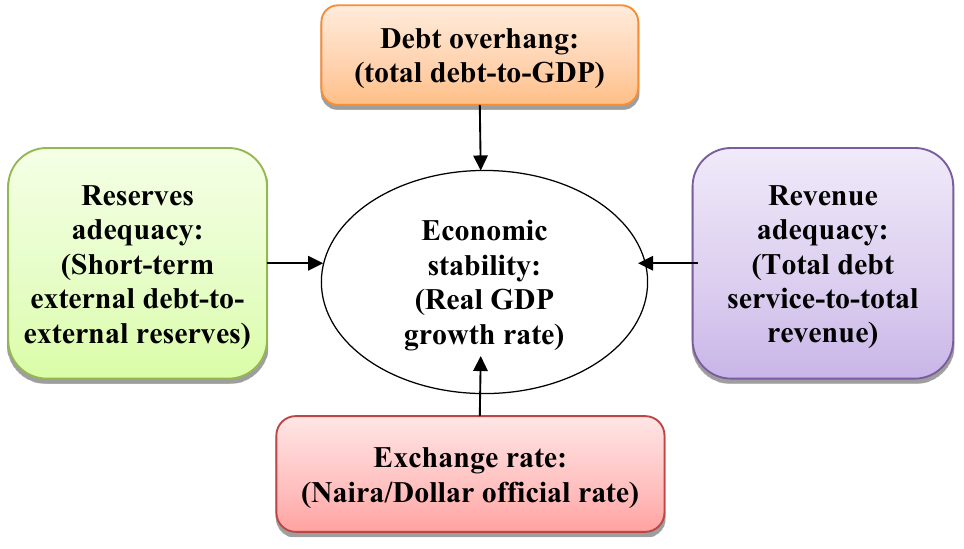
Fig. 1. Conceptual framework (Designed by the authors,